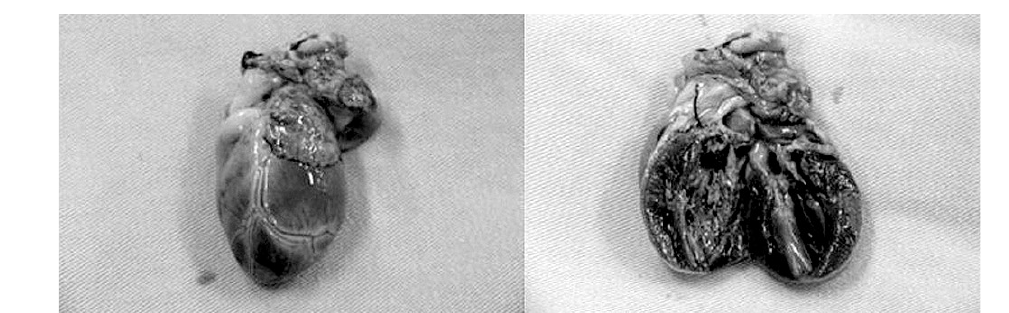
Fig. 1 - Fotografia do coração de coelho hipertrofiado